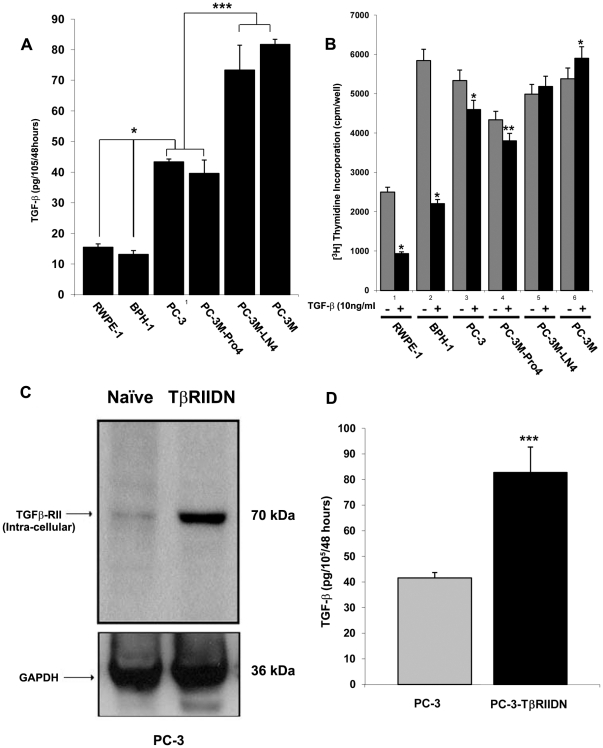
Tumor derived TGF-β regulates the expression of TβRs and secretion of TGF-β.
A. ELISA assay demonstrating that PC-3 cell lines express significantly (p<0.05) higher (×2–6 times) levels of TGF-β compared to benign prostate cell lines, BPH-1 and RWPE-1. Furthermore, PC-3M and PC-3M-LN4, secreted almost 2 times higher baseline levels of TGF-β1 compared to PC-3 and PC-3M-Pro4 cells, respectively, which are less invasive. B. A thymidine incorporation assay indicates that the growth of RWPE-1 and BPH-1 cells is inhibited significantly by exposure to TGF-β1. In comparison, the growth of PC-3 and PC-3M-Pro4 cells is only slightly inhibited, and PC-3M-LN4 and PC-3M cells show no significant response to TGF-β1 exposure. C. In all cancer cell lines (here we show PC-3 as an example), inhibition of TGF-β using the TβRIIDN construct results in significantly higher naïve TβRII expression, and D. higher TGF-β secretion. Similar findings are found in the findings in the more invasive cell lines. In comparison, there was no difference in the expression of TβRII in BPH-1 or RWPE-1 when they were infected with TßRIIDN (Table S1).